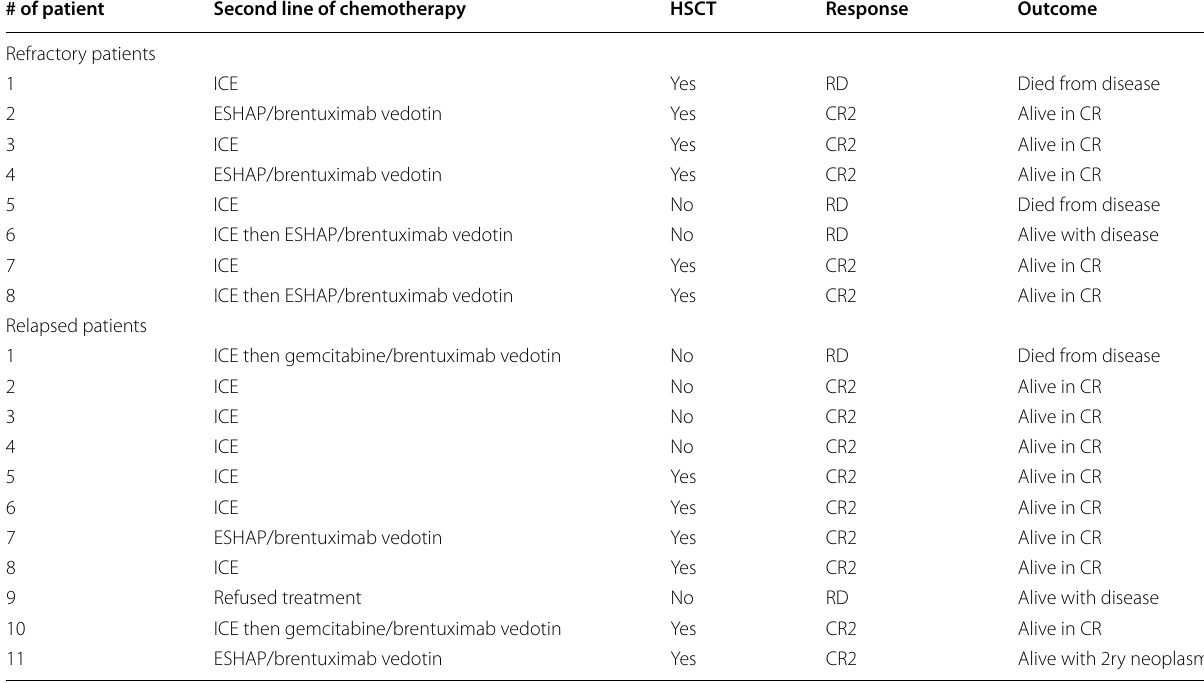
ICE ifosfamide/carboplatin/etoposide, ESHAP etoposide/solu-medrol/high dose ara-c/platinum-cisplatin, HSCT hematopoietic stem cell transplant, CR2 second complete remission, CR complete remission, RD refractory